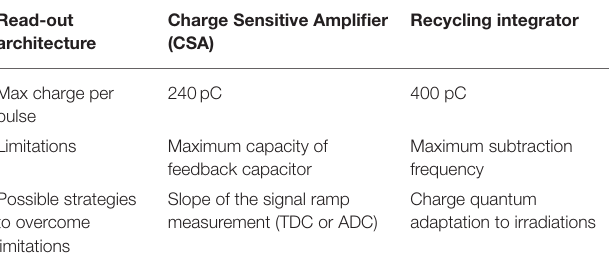
TABLE 1 | Summary of the main characteristics of two possible read-out architectures. Read-out